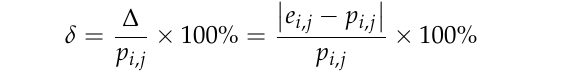
Figure 18. Relative error number distribution when separating mixed data. It is seen from Figure 16 that the relative error when separating mixed data is mostly within 10%. The numbers of samples for which the relative error is more than 10% ac- counts for 3.94%. Therefore, this method is feasible to a certain extent. 5. Discussion of the Separation Methodology The human behavior, type of equipment, climates, and functions of different build- ings are different, which leads to obvious differences in the power consumption charac- teristics of different buildings. To verify the applicability of the methodology for identify- ing and separating mixed data, on the premise of the successful verification of Building A, Buildings B and C, having different areas and functions, are selected as samples for further verification. The results show that the methodology is also applicable to buildings with other functions and climates, of which the identification accuracy is above 90%. A comparison of identifying and separating data is shown in Figure 17 and Table 6. As seen in Figure 19, the trend of separation is basically consistent with the actual situation, and the separation power consumption is close to the actual value.